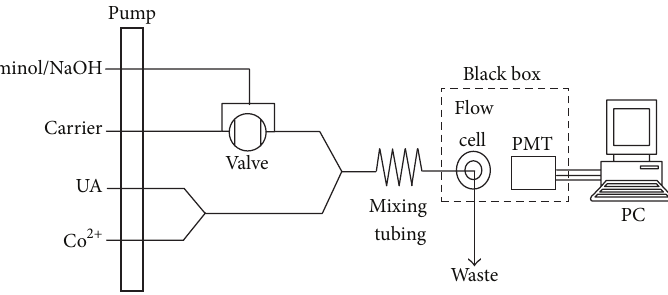
Figure 2: Schematic diagram for the determination of UA.